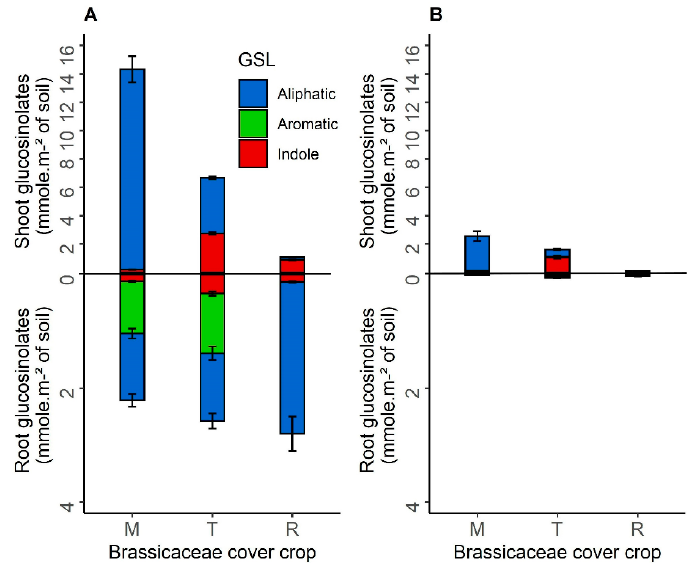
Figure 2. Mean shoot and root glucosinolates production function of the total dry matter biomass of each species of Brassicaceae cover crop per square meter of soil (mmol m − 2 of soil) in sole crops in 2016 ( A ) and 2017 ( B ). Abbreviation letter refers to Brassicaceae cover crop with M for brown mustard, T for turnip rape, R for fodder radish. Error bars represent standard errors.